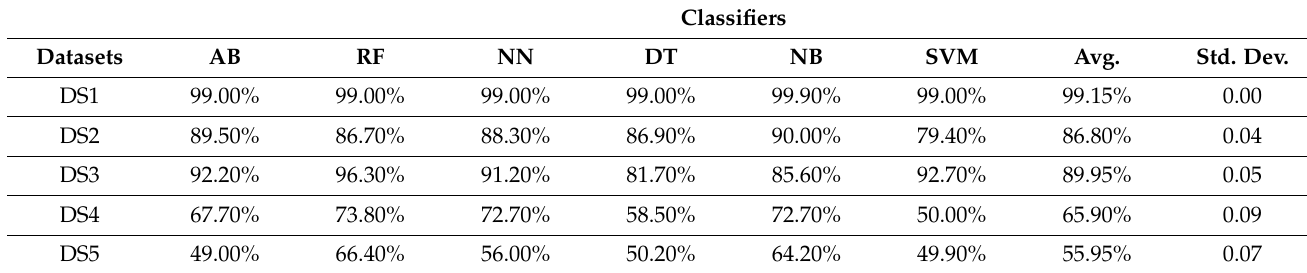
Table A5. AUC of classifiers trained on small